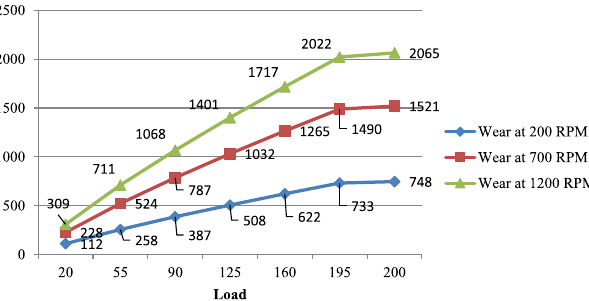
Fig. 8. Wear vs load at constant RPM for Al6061+ SiC.